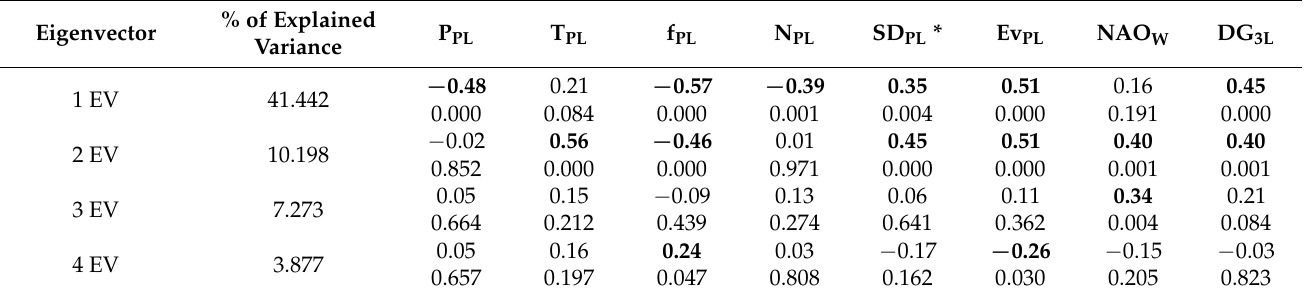
Table 2. Correlation coefficients between eigenvectors (EV) of ND LF and the area climatic elements (P PL , T PL , f PL , N PL , SD PL , Ev PL ), the winter NAO index (NAO w , PC-based) and the DG 3L index characterizing the heat transport intensity to the north through the thermohaline circulation in the North Atlantic